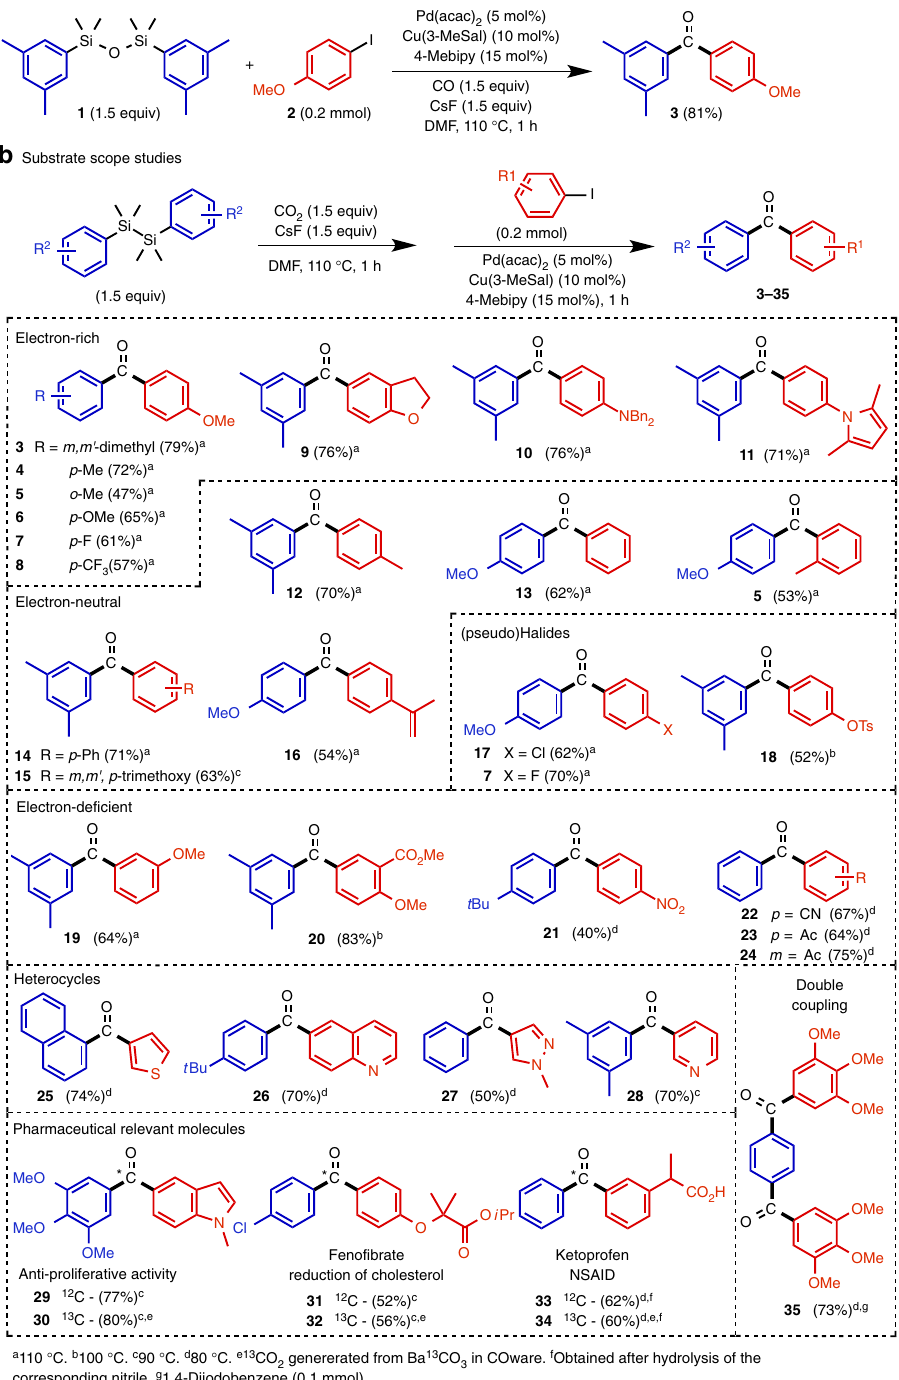
Figure 2 | Substrate scope and applications to relevant pharmaceuticals possessing a diarylketone core. The top row reaction shown in a reveals the reaction conditions identified for the carbonylative Hiyama-Denmark coupling between a diaryldisiloxane and an aryl halide. In b studies on the substrate scope are illustrated for the synthesis of diarylketones from an initial cooperative redox activation of CO 2 and a diaryldisilane to carbon monoxide and the corresponding diaryldisiloxane followed by the Pd-catalysed carbonylative cross coupling with an aryl iodide. All yields are based on an average of two runs.